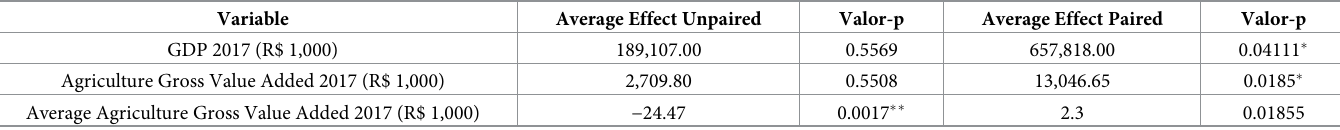
Table 5. t statistic for paired and unpaired economic variables for the control and treatment groups.